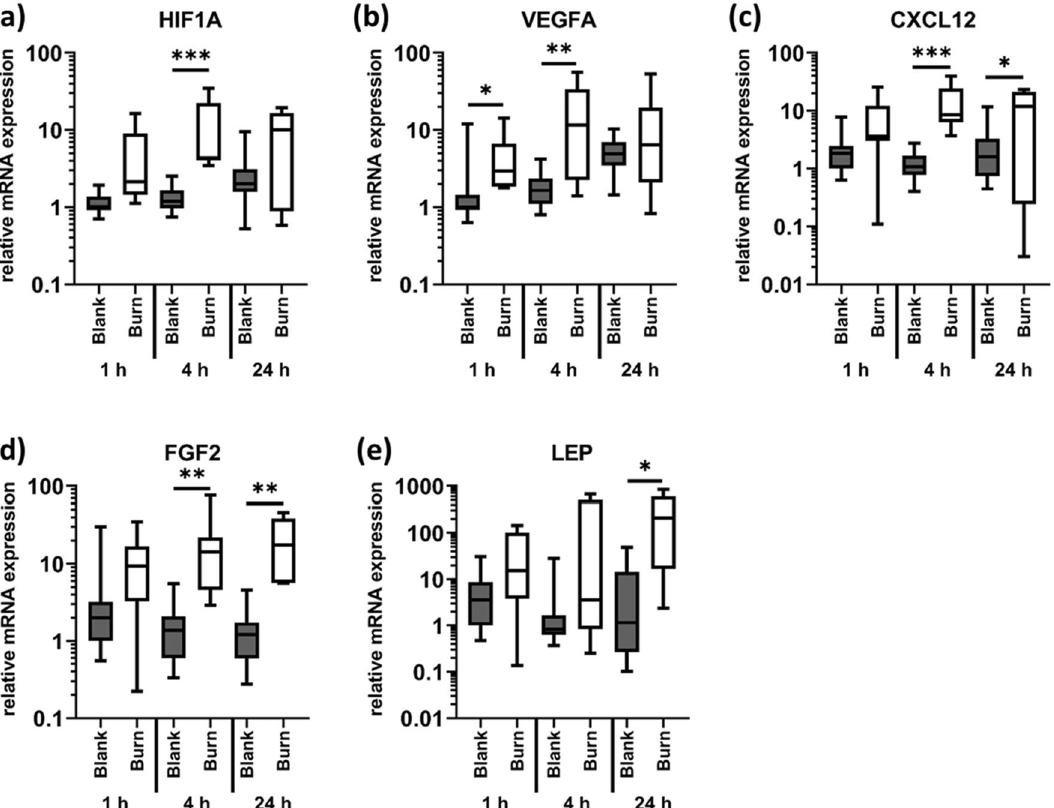
Figure 4. Burn injury strongly enhances the expression of genes involved in angiogenesis. Contact burn injuries were created on fresh human skin explants by applying a heated metal block (100 °C). Biopsies were collected after 1, 4 and 24 h. Relative mRNA expression levels of ( a ) HIF1A, ( b ) VEGFA, ( c ) CXCL12, ( d ) FGF2 and ( e ) LEP were determined by RT-qPCR, normalizing target gene expression to the averaged expression of RPLP0 and TBP. Data are presented as median (line) the interquartile range (box) and the minimum and maximum values (whiskers) from three individual skin explants. p-values < 0.05 were considered as